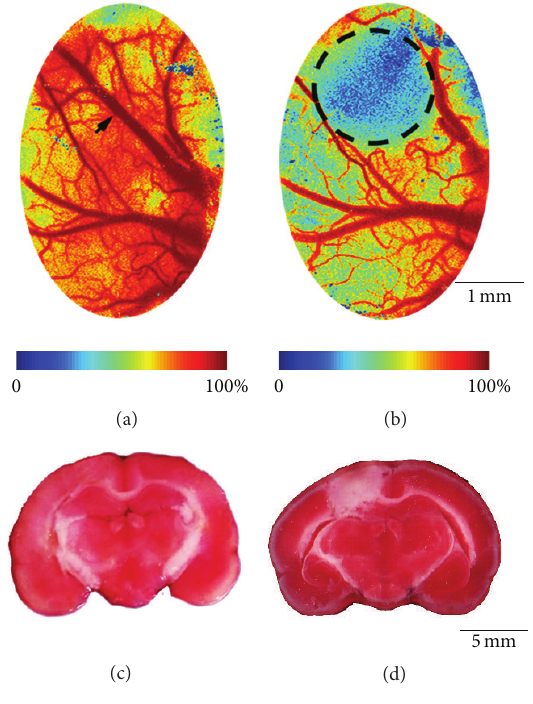
Figure 2: Laser speckle imaging (LSI) and triphenyltetrazolium chloride (TTC) staining results of photothrombosis. LSI images before (a) and after (b) photothrombotic stroke. The flow in the vessel (see the arrow area) apparently disappeared immediately after the thrombi formed, indicating the success of stroke model. The color map stands for the relative speed of blood flow, and the circle shows the main affected area due to ischemia. Representative TTC stained coronal sections of brain slices in Control group (c) and Stroke group (d). Unstained area depicts infarcted S1HL after photothrombotic